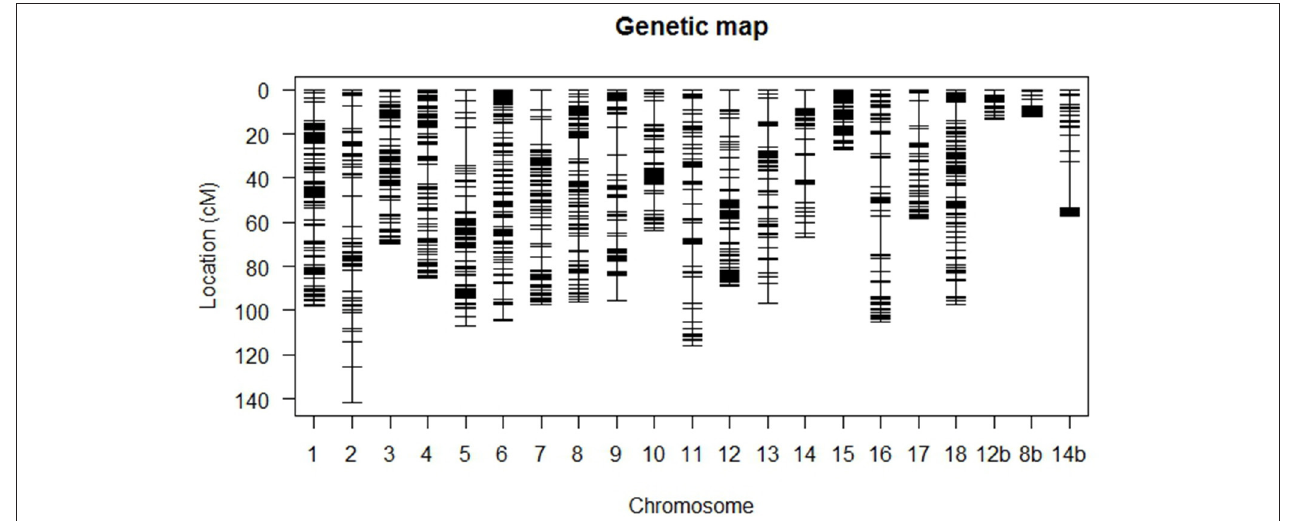
FIGURE 2 | High-density genetic linkage map based on SNP markers. Linkage groups 1–18 represent chromosomes I to XVIII of cassava v5.1 assembly. Chromosomes VIII, XII, and XIV are represented by two linkage groups each and the second group is denoted by b.